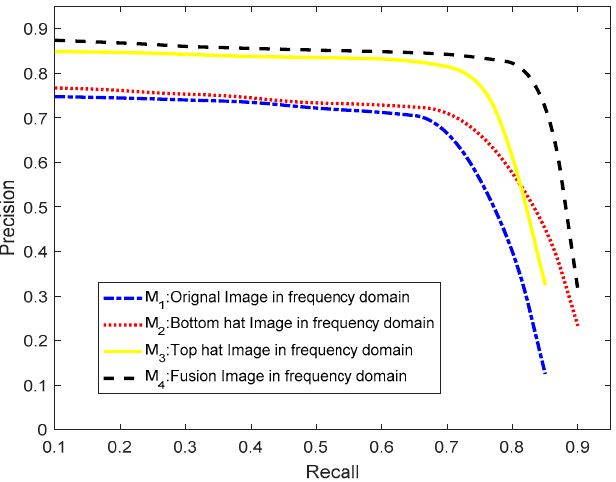
Figure 10. Fusion image effect for ship candidate extraction performance analysis.